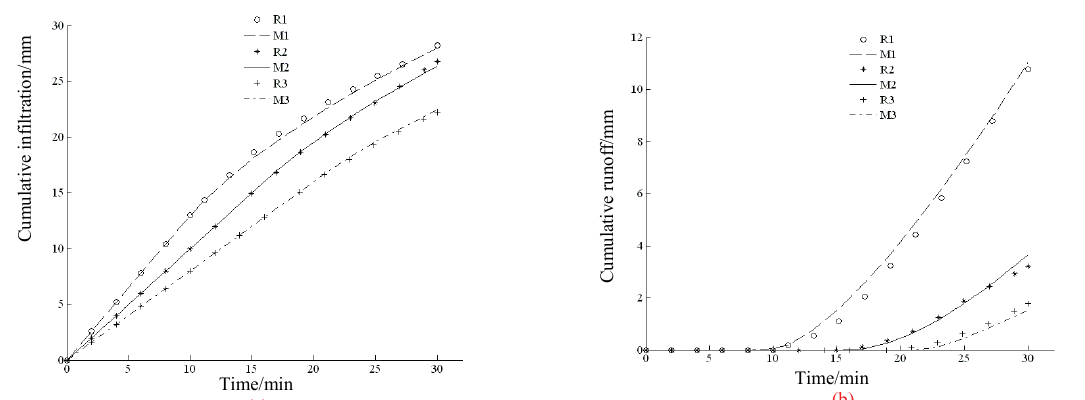
Fig. 1 The measured and simulated cumulative infiltration (a), and (b) cumulative runoff, under different rainfall intensity in runoff